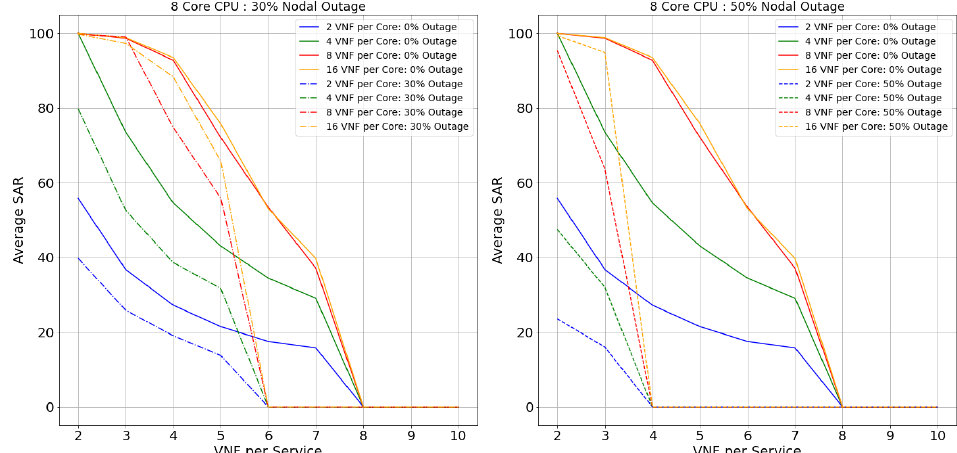
Figure 15. SAR: Netrail topology with nodal outage—8 Core CPU.